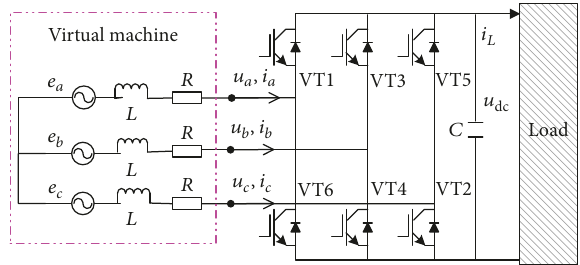
Figure 1: Topology of three-phase PWM